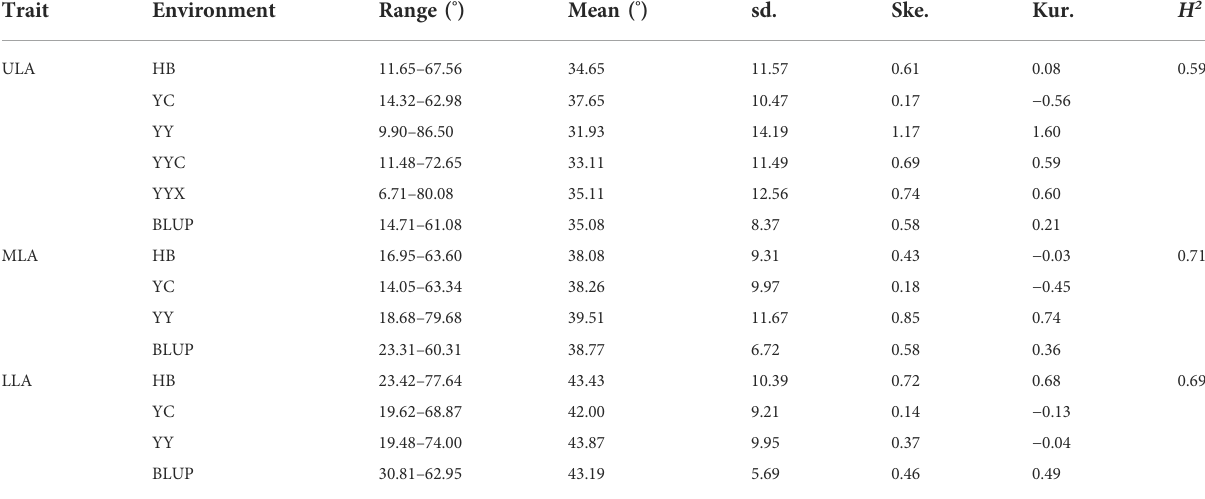
TABLE 1 Descriptive statistics for leaf angle-related traits of maize in the association mapping panel in different environments.